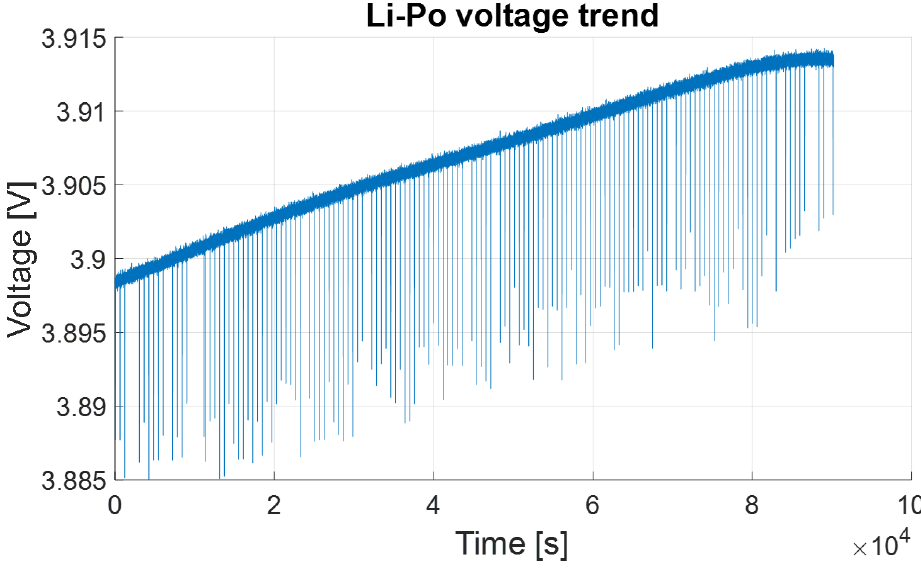
Figure 10. Li-Po voltage trend with radio transmissions every 10 min and ∆ T = 10